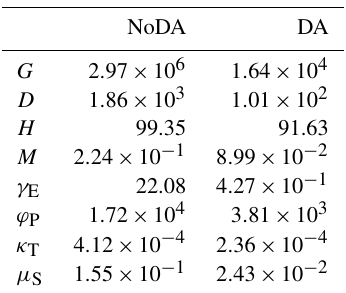
Table 3. RMSE of the no data assimilation (NoDA) experiment and the data assimilation (DA) experiment in which all observations are assimilated every 10 years, with 5000 ensembles, in experiment 2 (see Sect. 3.2).